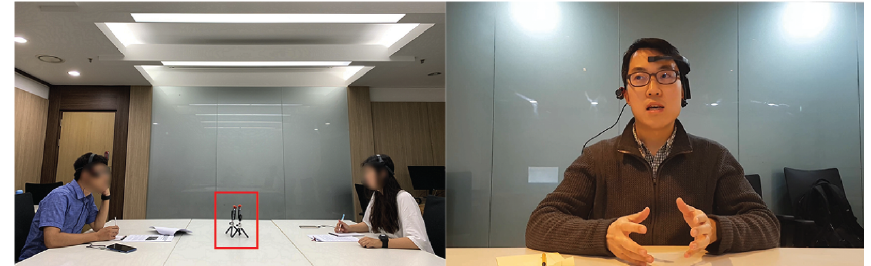
Figure 3. Scenario ( left ) and Sample image ( right ) in K-EmoCon dataset